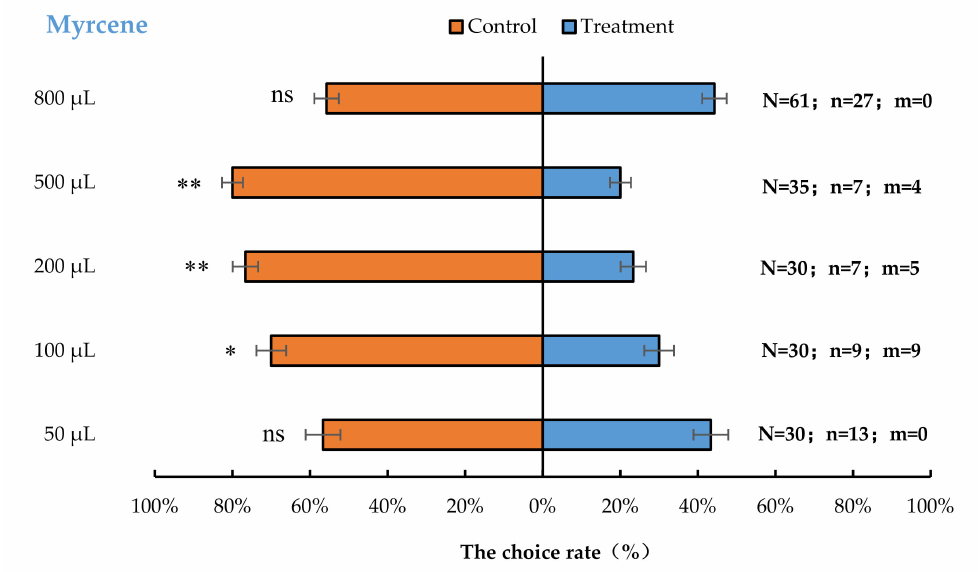
Figure 2. Behavioural responses of A. bungii females to different quantities of myrcene. Note: N = number of responsive A. bungii ; n = number of A. bungii females choosing the treatment; m = number of A. bungii that made no choice. ns = no significant difference; * = significant dif- ference at the 0.05 level. ** = significant difference at the 0.01 level (the binomial test). Aromia bungii females exhibited significant behavioural repulsion to 800 µ L borneol ( p < 0.01), but no significant behavioural response to 200 µ L ( p = 0.20) and 500 µ L ( p = 1.00) borneol compared with the control (Figure 3).